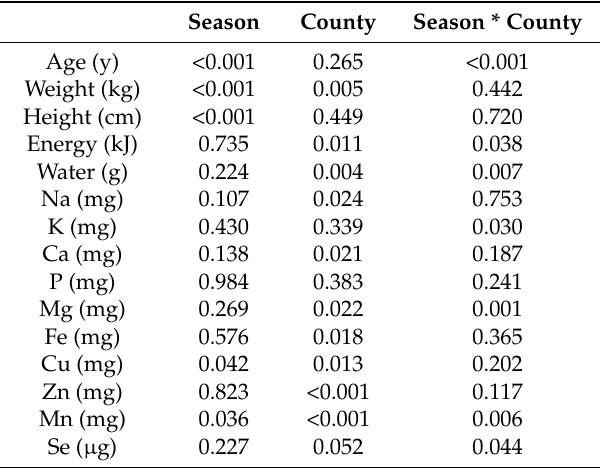
Table 3. p -values of ANOVA with two fixed factors, counties (3 levels), and seasons (2 levels). Season County Season * County